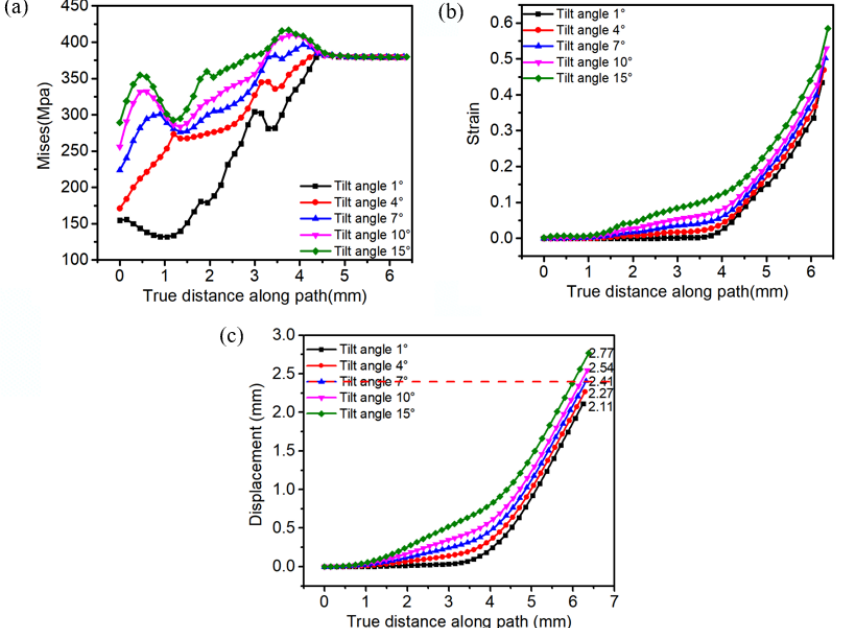
Figure 7. Values of equivalent stress ( a ), equivalent plastic strain ( b ), and radial displacement ( c ) at different nodes on the path under different values of α.